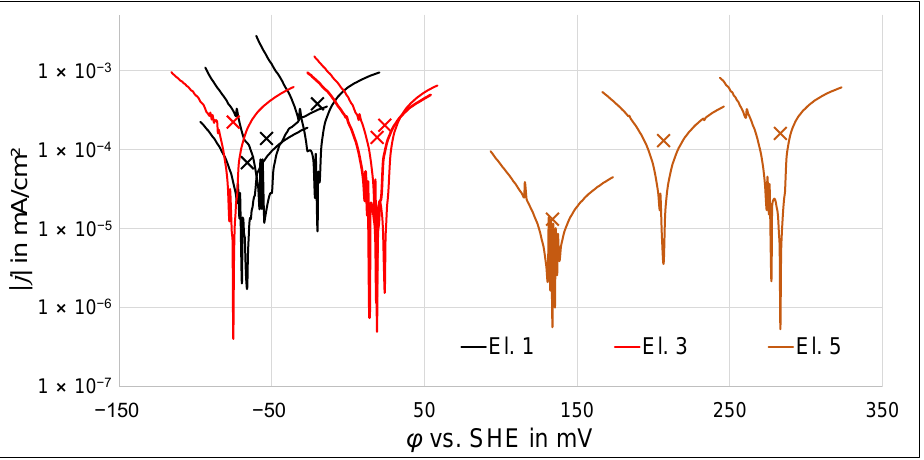
Figure 3. j – ϕ curves in electrolytes no. 1, 3, and 5 within the range of ϕ corr ± 40 mV; the crosses mark Figure 3. j – φ curves in electrolytes no. 1, 3, and 5 within the range of 𝜑 corr ± 40 mV; the crosses mark the 𝜑 corr and 𝑗 corr values of every curve. the ϕ corr and j corr values of every Table 2. Average values and standard deviations of 𝜑 corr and 𝑗 corr (Equation (13)) in different elec- trolytes.